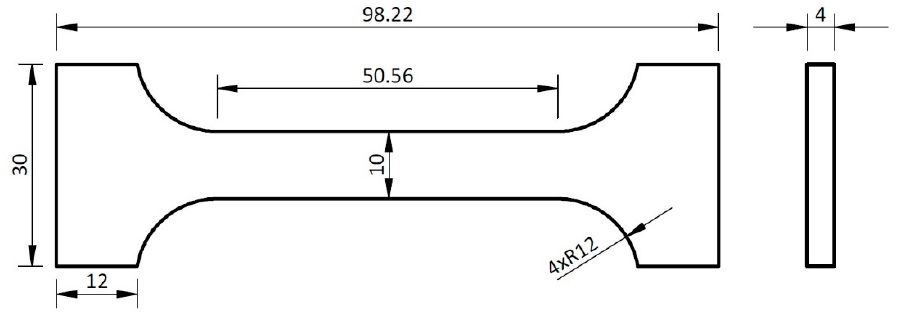
Figure 1. Solder test body for static tensile strength test.